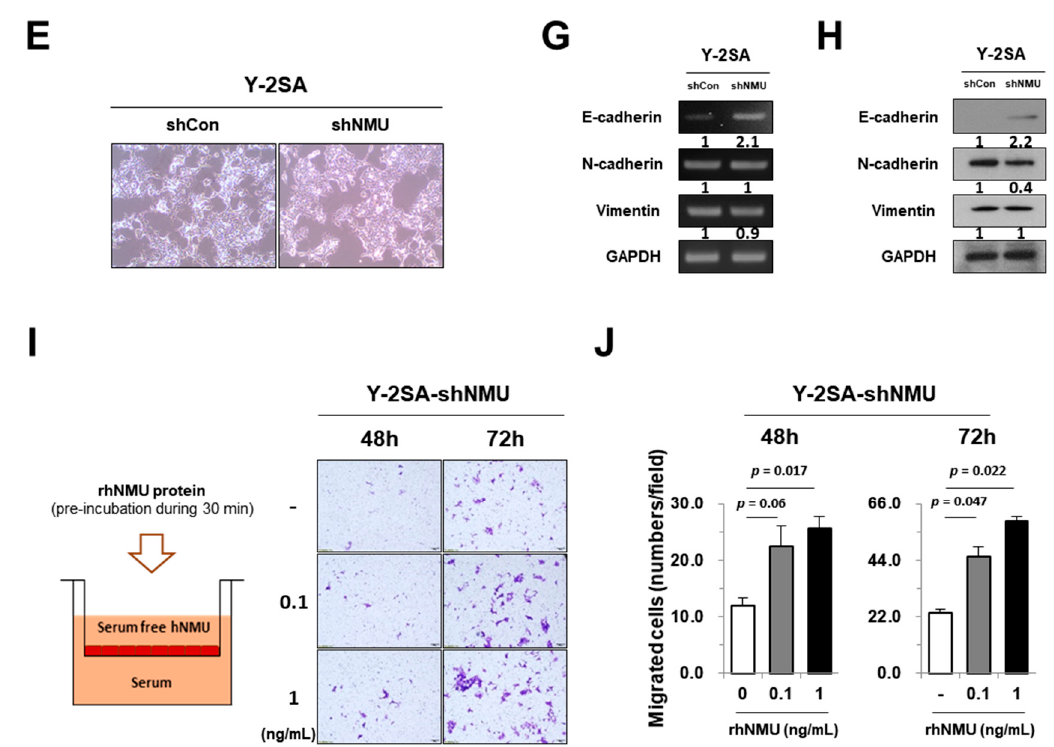
Figure 4. Effects of NMU downregulation on YAP1-overexpressing cells. ( A ) Western blot analysis of YAP1 and NMU in the indicated cells. ( B ) Concentration of secreted NMU in the culture medium. ( C ) Cell adhesion analysis. Adherent cells were stained and counted, and the proportion of stained cells was expressed as a percentage with respect to the control. ( D ) Migration ability assessed by the Transwell assay as described in Materials and Methods. Representative images of migrating cells are displayed (left) with quantification (right) (magnification, ×100). ( E ) Morphological changes of Y-2SA-overexpressing MIA PaCa-2 cells with or without shNMU (magnification, ×100). ( F , G ) Changes in mRNA expression of EMT markers assessed by real-time qPCR and RT-PCR. ( H ) Western blot analysis of EMT markers was performed with the indicated antibodies. ( I ) Flow diagram and migration ability assessed by the Transwell assay as described Materials and Methods (magnification, ×100). ( J ) Quantification of migrating cells in the lower chamber. Values are expressed as the mean ± SEM.